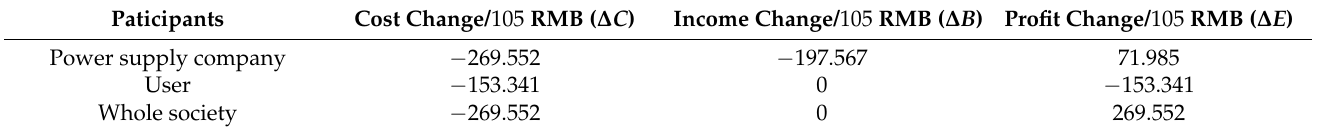
Table 4. Cost, income, and profit changes of each